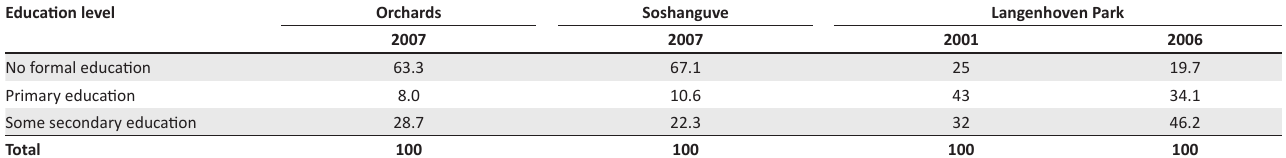
Totals are given as